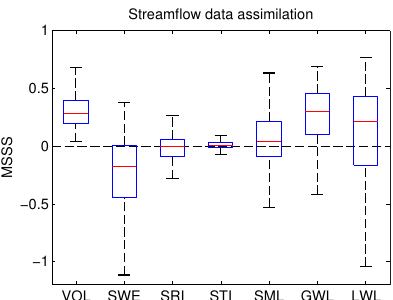
Figure 5. Box plot of the mean square skill score for each variable when assimilating streamflow at the outlet. The open loop is used as a reference. Outliers are not shown for visibility